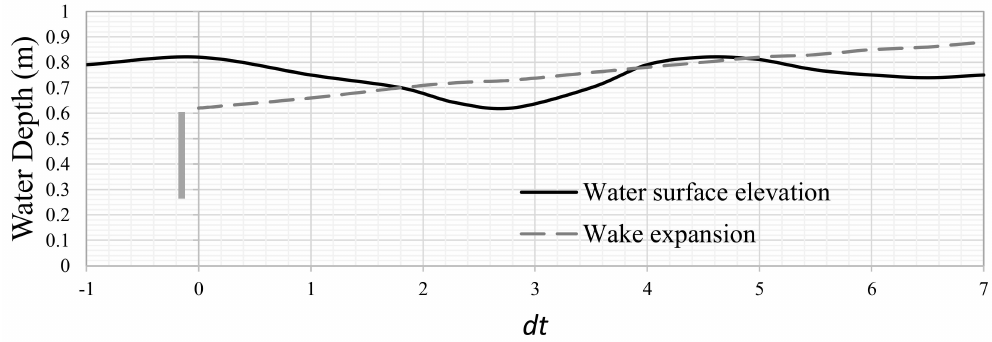
Figure 2. Wake expansion effect with free surface